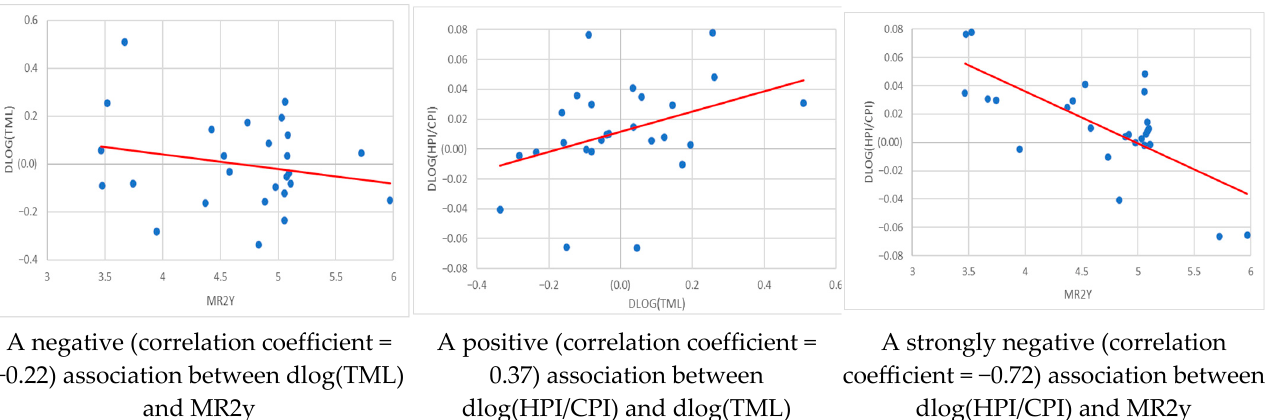
Figure 3. Scatterplots of total mortgage lending quarter-on-quarter changes, real house prices quarter-on-quarter changes and mortgage rates of New Zealand, 2016Q2–2022Q3.